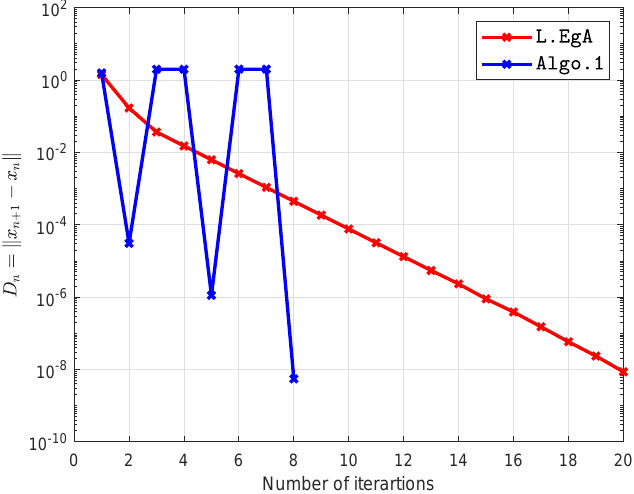
Figure 9. Example 3 while u 0 = ( 1.5,1.7 )